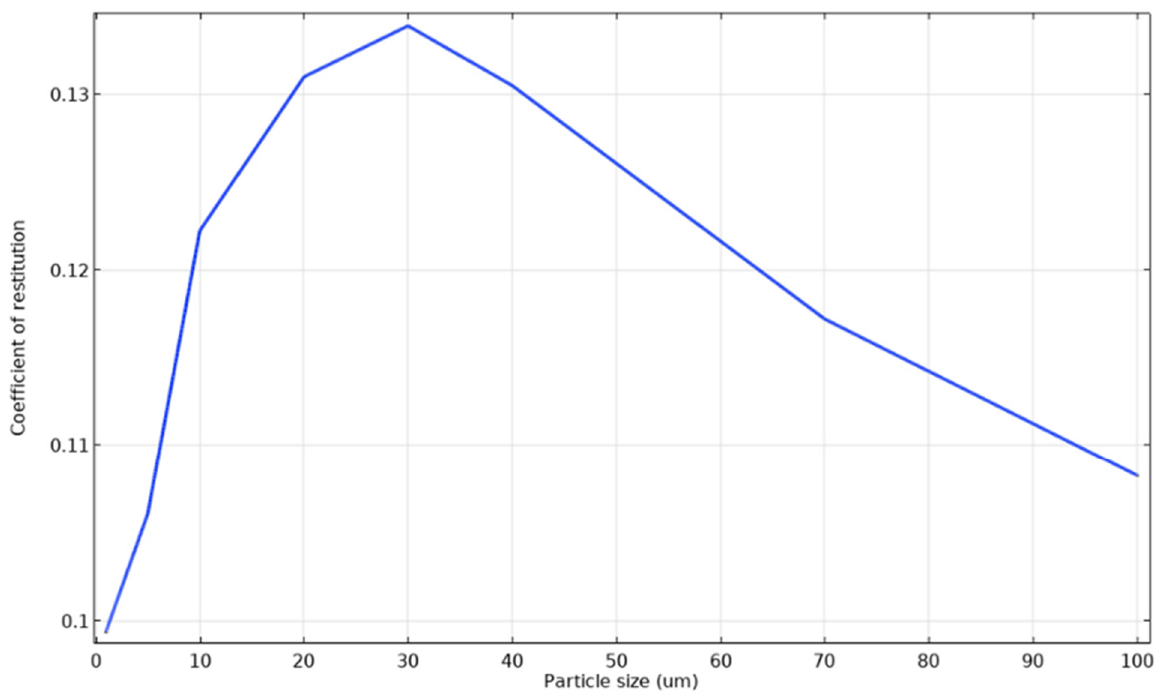
Figure 6. Variation of coefficient of restitution against particle size.